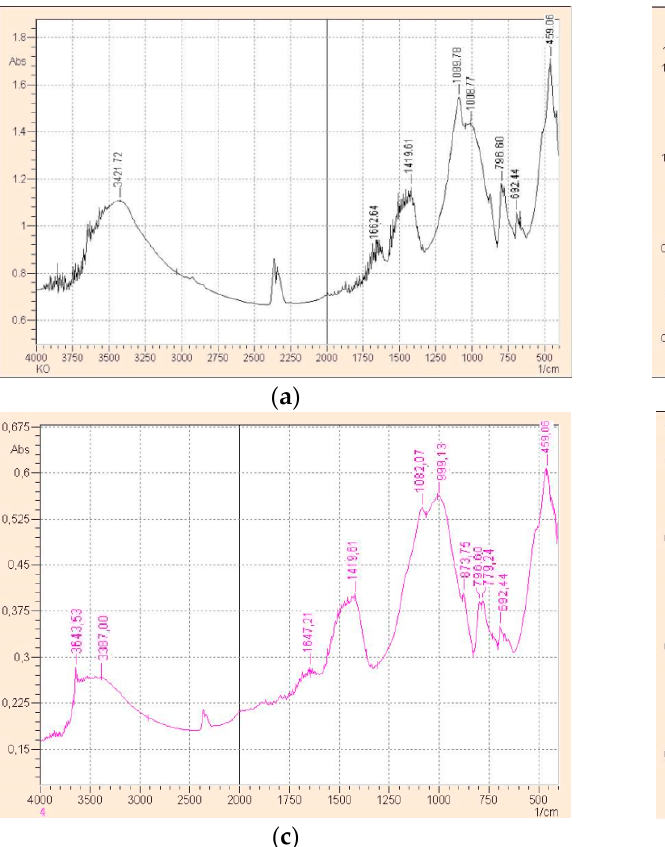
( b ) Figure 6. Microstructure of cement composite at 1000-fold magnification: ( a ) reference sample, ( b ) modified sample. The microstructure of the sample in Figure 7 clearly shows that chrysotile nanotubes are evenly distributed among the phases of calcium silicate hydrates and their surface is fully covered with cement hydration products. This confirms the tendency of new for- mations to grow along the modifier fibers and evidences for the high adhesion between